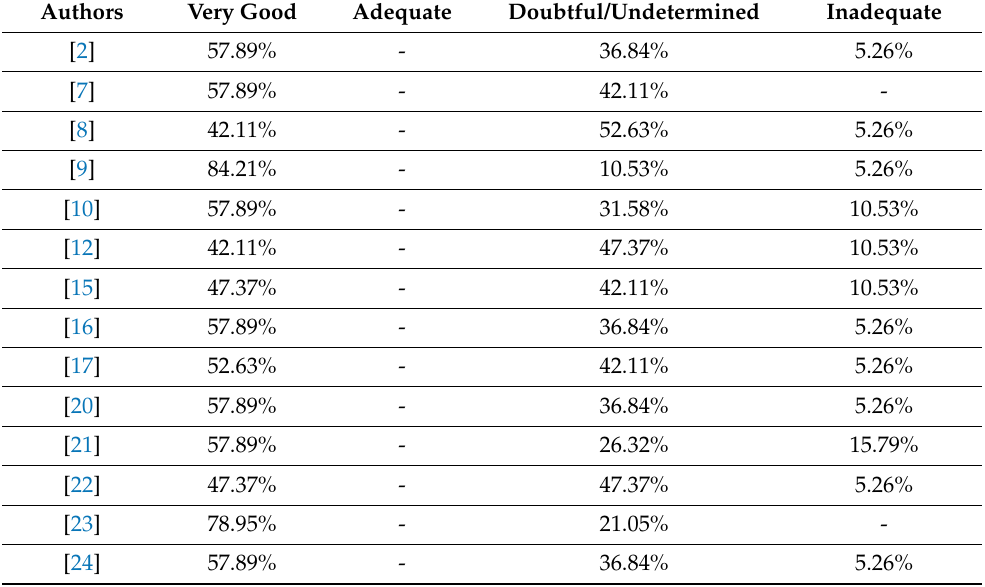
Table 5. Analysis of the quality of studies using the COSMIN